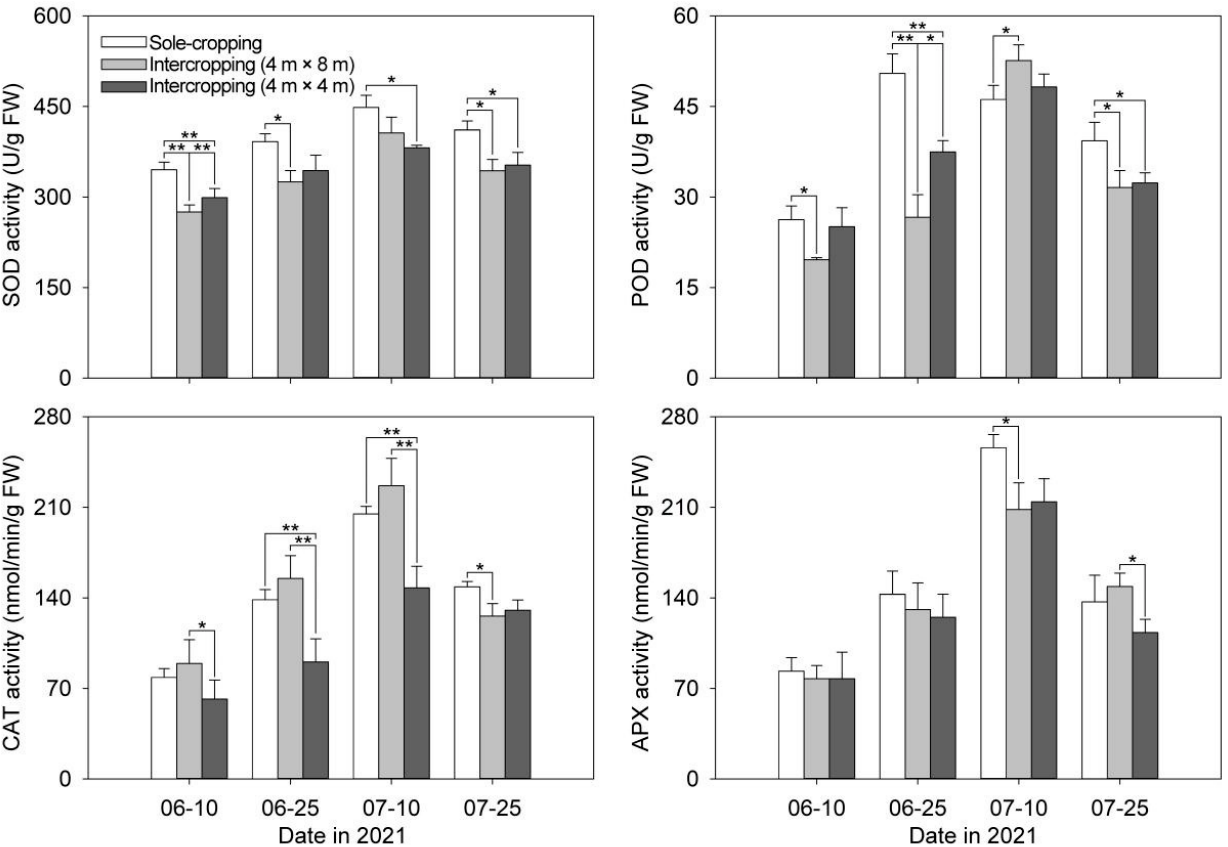
Figure 4. Effects of understory cultivation on antioxidant enzyme activities of P. ostii . Values represent mean ± SDs, and * or ** indicate significantly lower or higher among the sole-cropping P. ostii and intercropping P. ostii under C. illinoinensis with row spacing of 4 m × 8 m and of 4 m × 4 m according to Duncan’s multiple range test (* p < 0.05, ** p < 0.01).